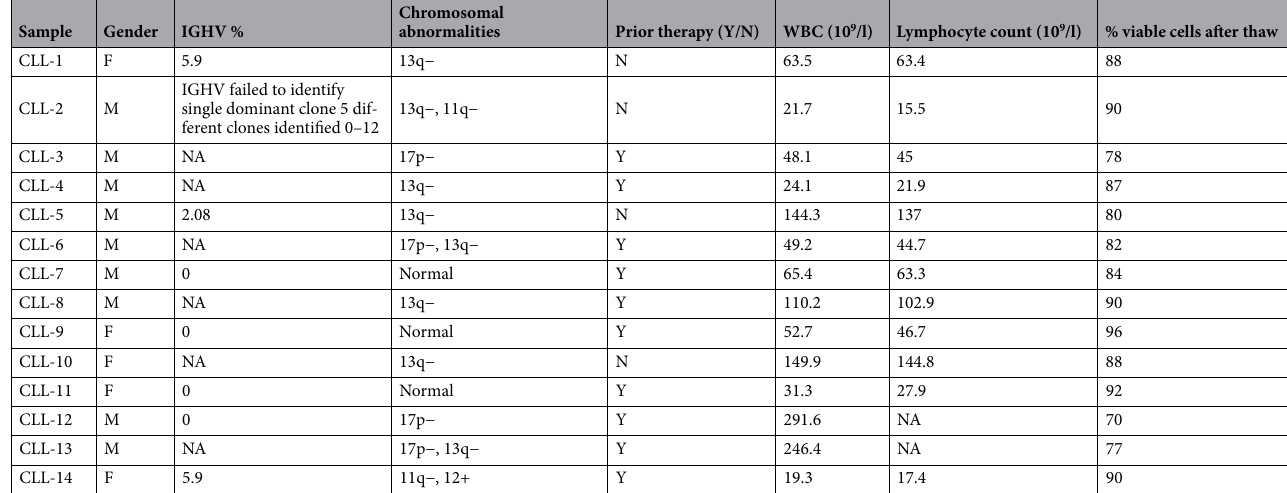
Table 4. Clinical features of CLL samples analysed by data dependant acquisition (DDA) to generate a CLL-specific spectral library for mapping data acquired by SWATH-MS. Prior therapy consisted of various combinations of glucocorticoid, chlorambucil, fludarabine, or fludarabine plus cyclophosphamide. IGHV refers to somatic mutation in the IGHV gene of CLL cells compared with the gene sequence of the nearest germ line, where < 2% was classed as UM-CLL and > 2% was classed as M-CLL. CLL samples were tested by interphase fluorescence in situ hybridization for del17p13 (17p−), del11q23 (11q−), trisomy 12 (12+), and del13q14 (13q−). 17p and 11q− are regarded as high-risk chromosomal